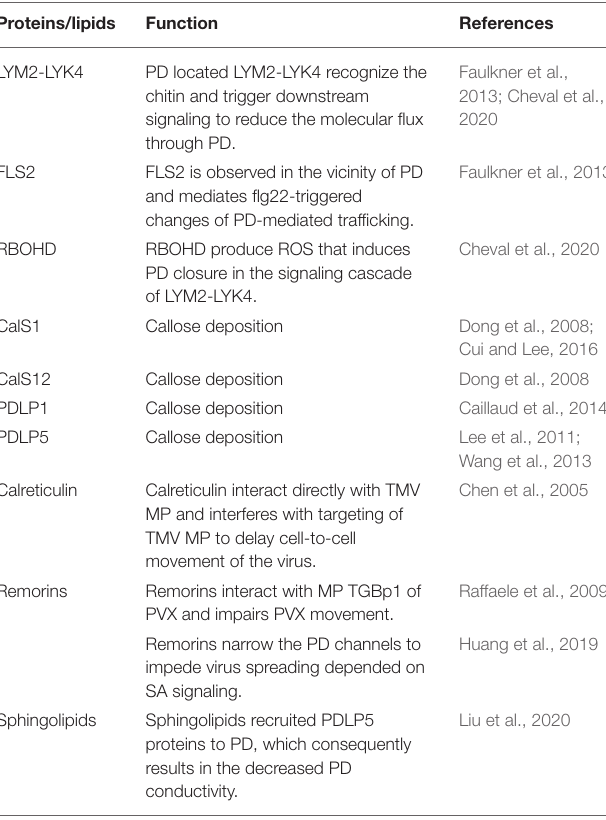
TABLE 2 | Experimentally studied Host proteins/lipids that can regulate the plasmodesmata for plant defense. Proteins/lipids